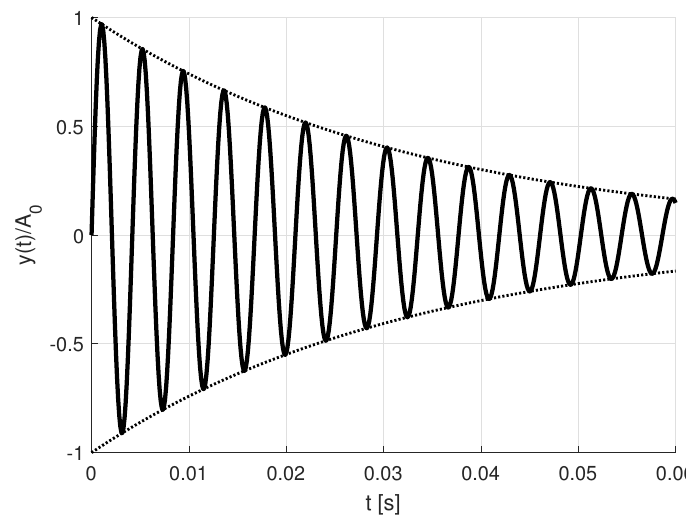
Figure 4. Single damped